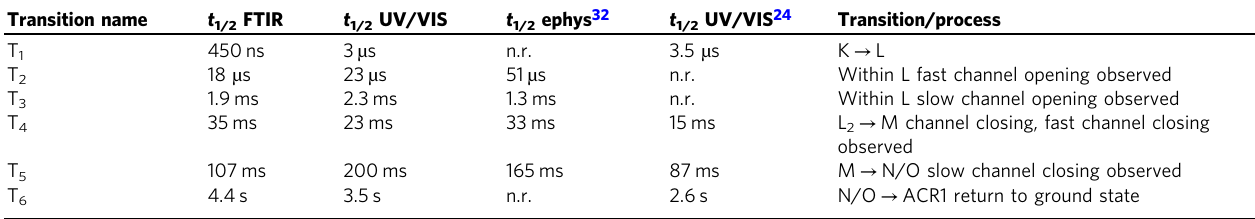
Table 1 Gt ACR1 photocycle